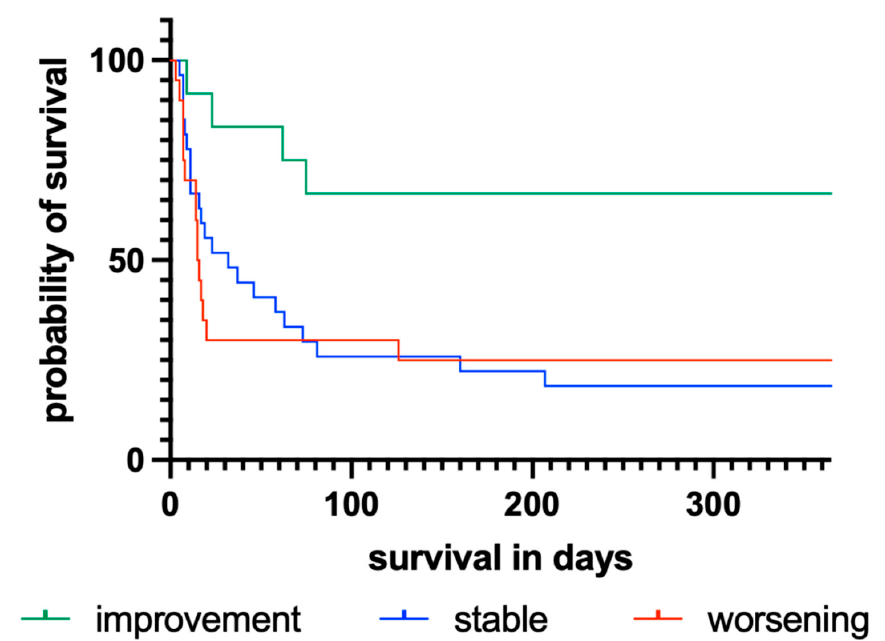
Figure 2. Kaplan–Meier diagram illustrating the influence of an improved, stable, or worsening outcome of the last EEG compared to the first EEG within 14 days after CPR.